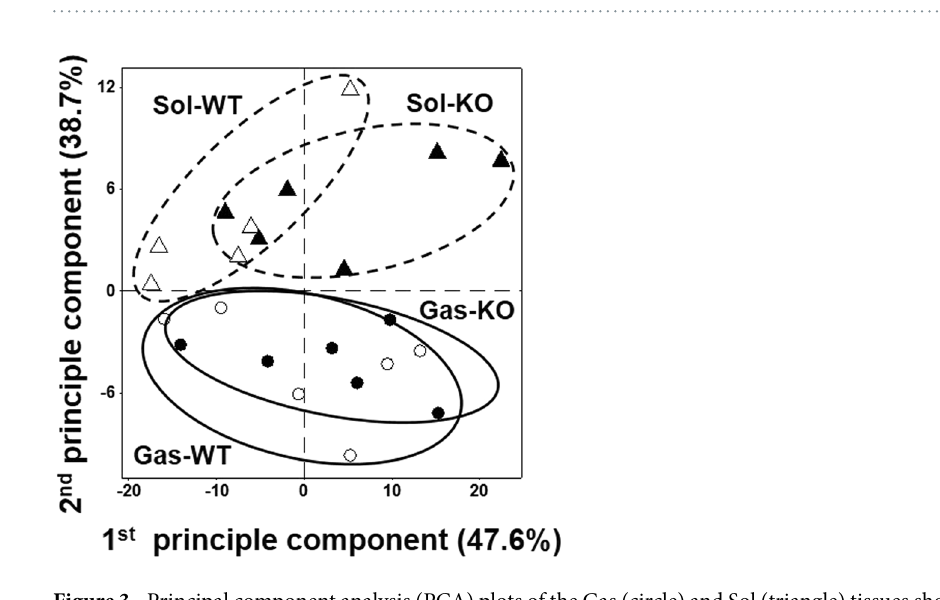
Figure 3. Principal component analysis (PCA) plots of the Gas (circle) and Sol (triangle) tissues showing the differences between wild type (WT, empty symbols) and p53 knockout (KO, filled symbols) mice based on quantified results of 329 lipids from each